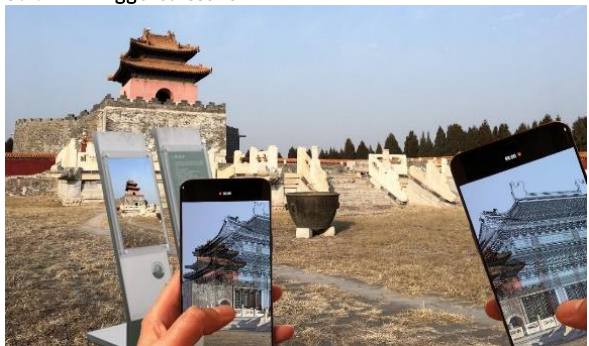
Figure 30. Scanning enhanced